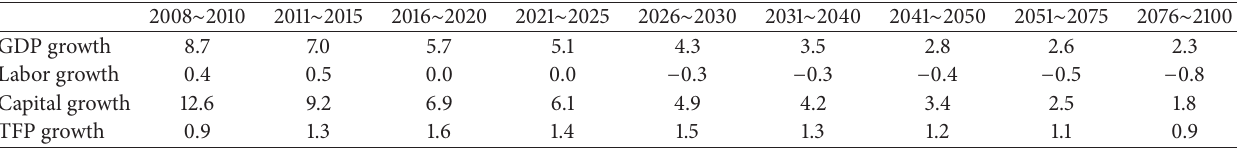
Figure 2: Comparison of simulated land use and real land use: (a) the real land use area in 1990, 2005, and 2010; (b) simulated land use area in 1990, 2005, and 2010 (unit: 1000km 2 ). Table 3: The economic growth under the CES scenario in 2008–2100 (unit: